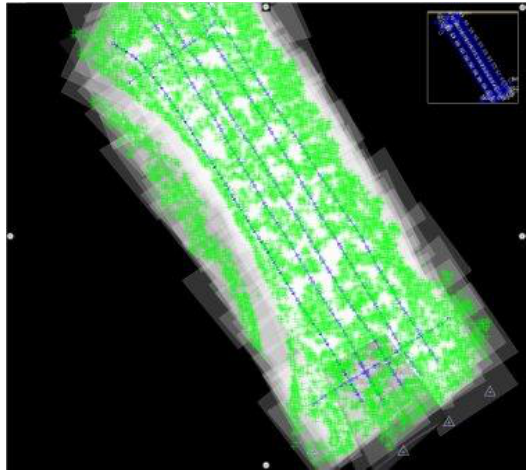
Figure 5: Canon image block with automatic tie points from MATCH-AT (August, 23 rd